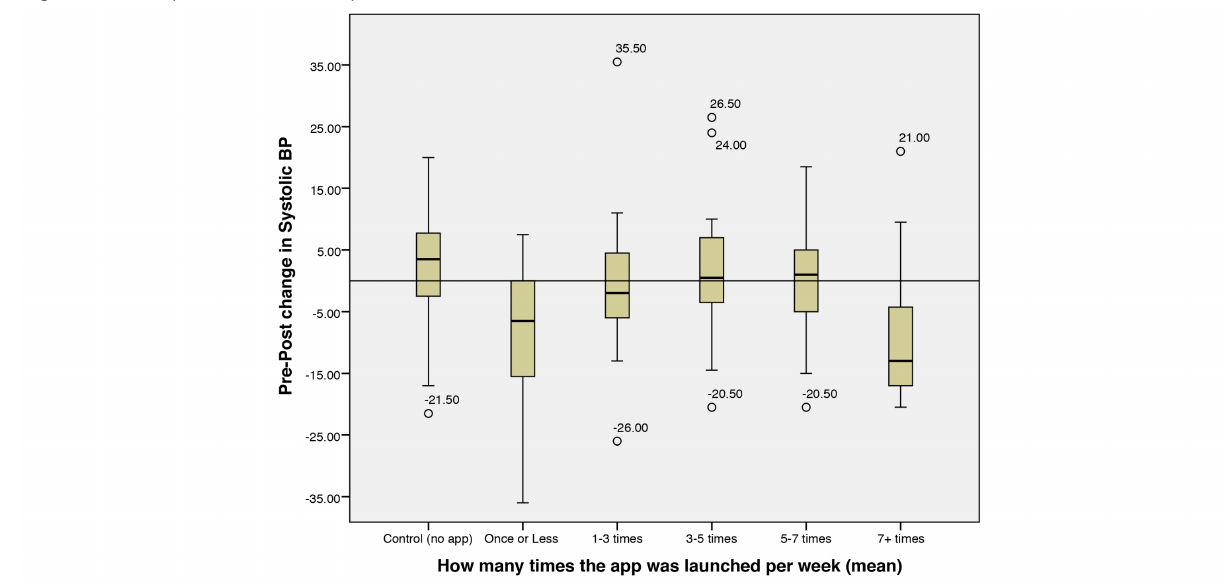
Figure 9. Boxplot showing no app (control) and grouped app launches per week (treatment) against observed changes in systolic blood pressure (BP; mm Hg). Outliers are plotted as individual